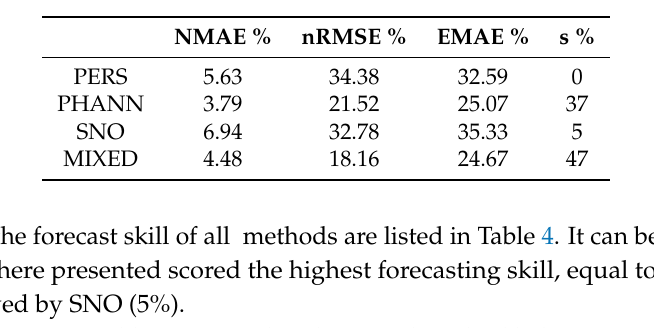
Figure 10. Daily EMAE% for 2017 for the mixed method and mean values of all forecasting methods. Table 4. Results of case